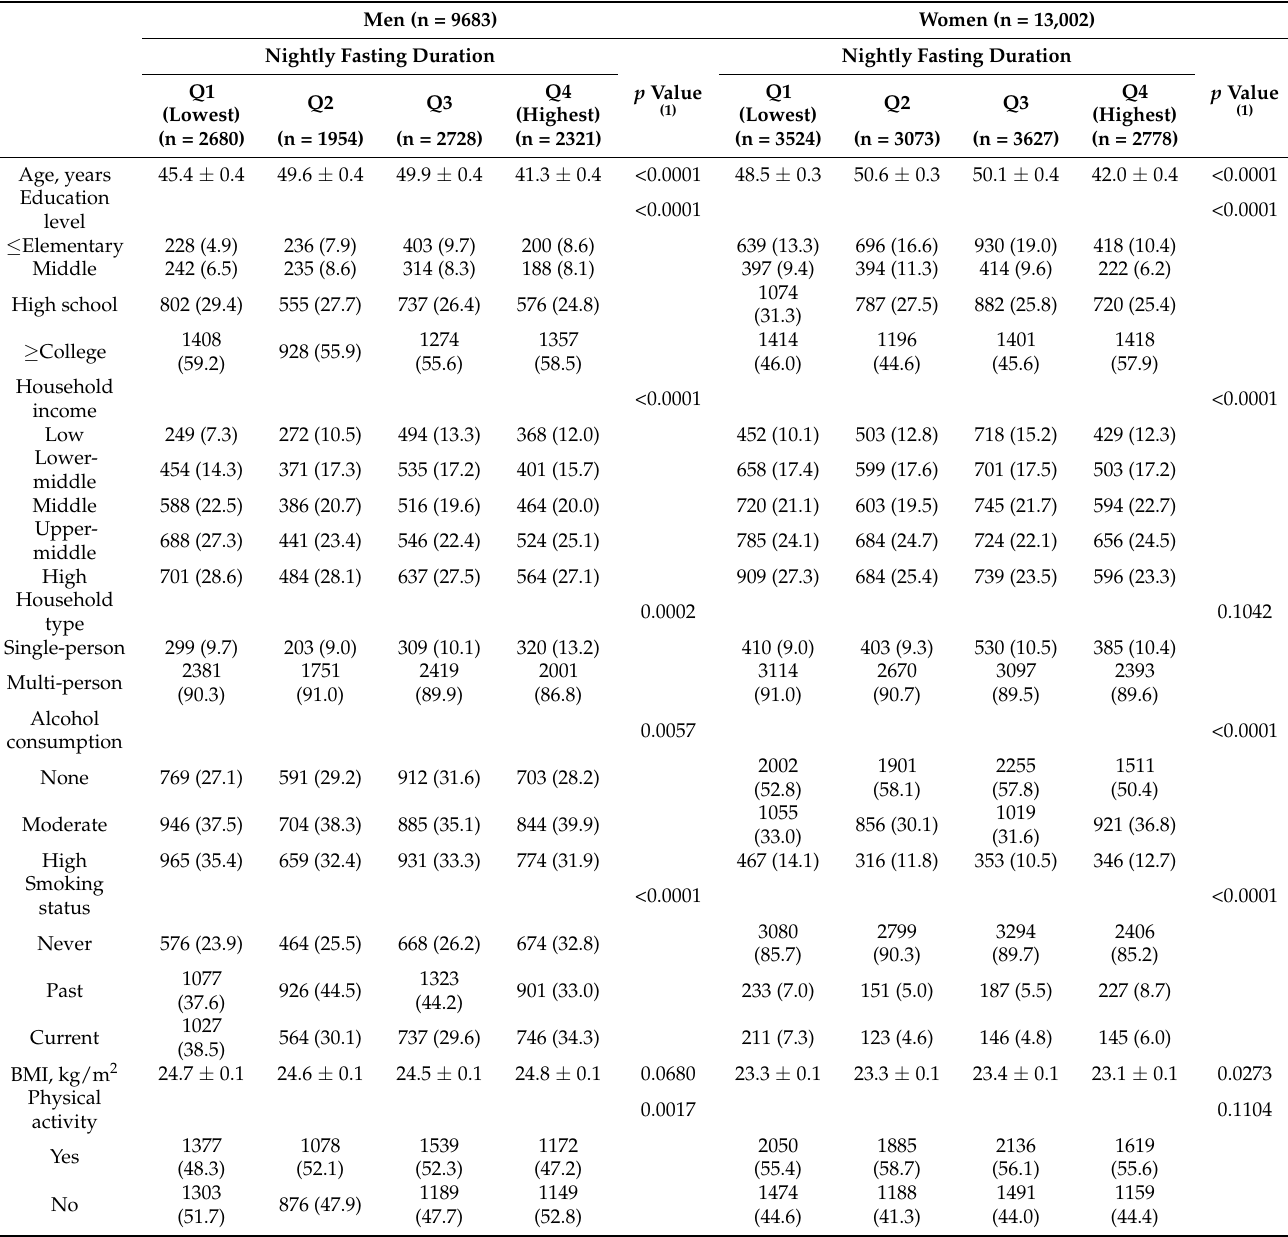
Table 1. General characteristics of study participants according to quartiles of nightly fasting duration in Korean